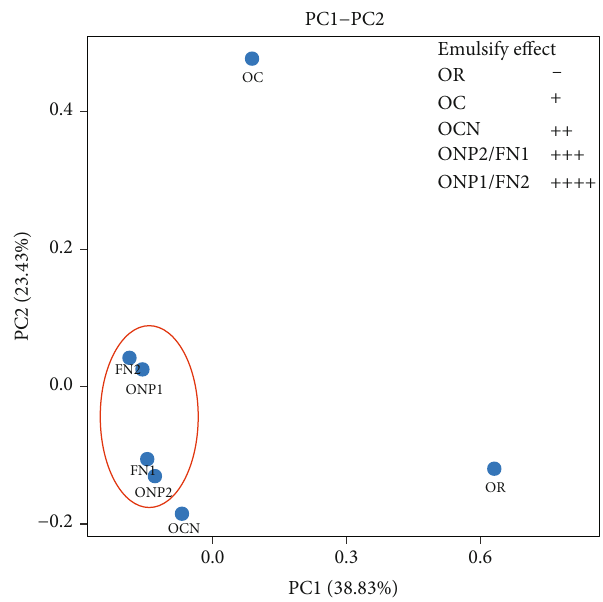
Figure 3: Oil spreading test represents the surfactant production ability by indigenous microbial consortia; “ + ” indicated the emulsify level of crude oil; OR used as the